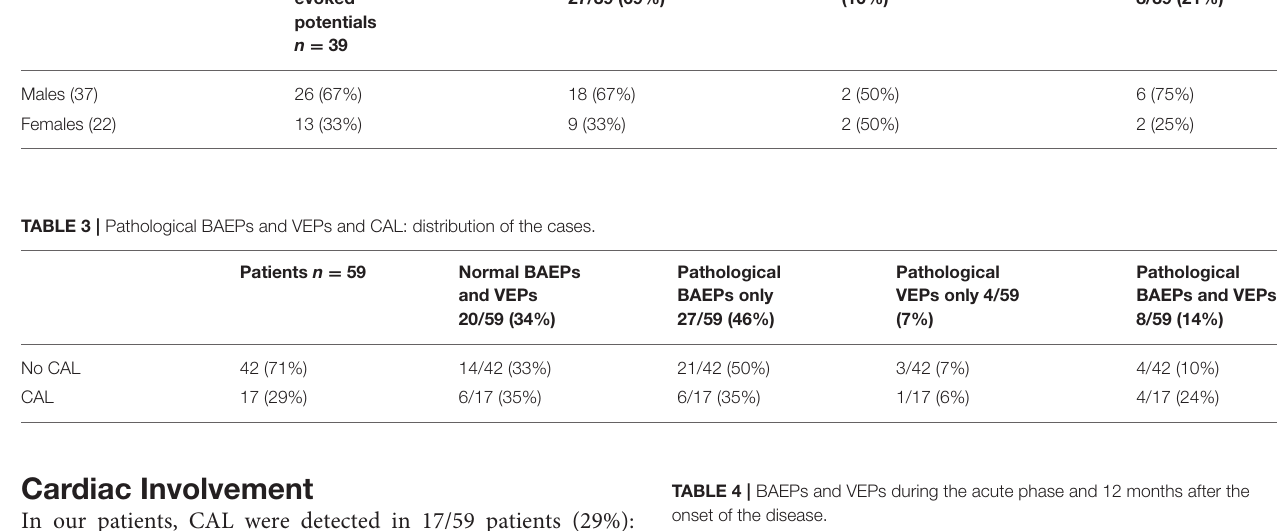
Patients with pathological evoked potentials normalized during the follow-up